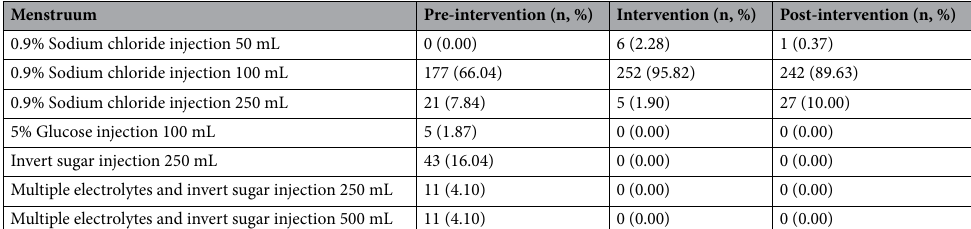
Table 7. Menstruum of Lipo-PGE 1 in pre-, during, and post-intervention periods.